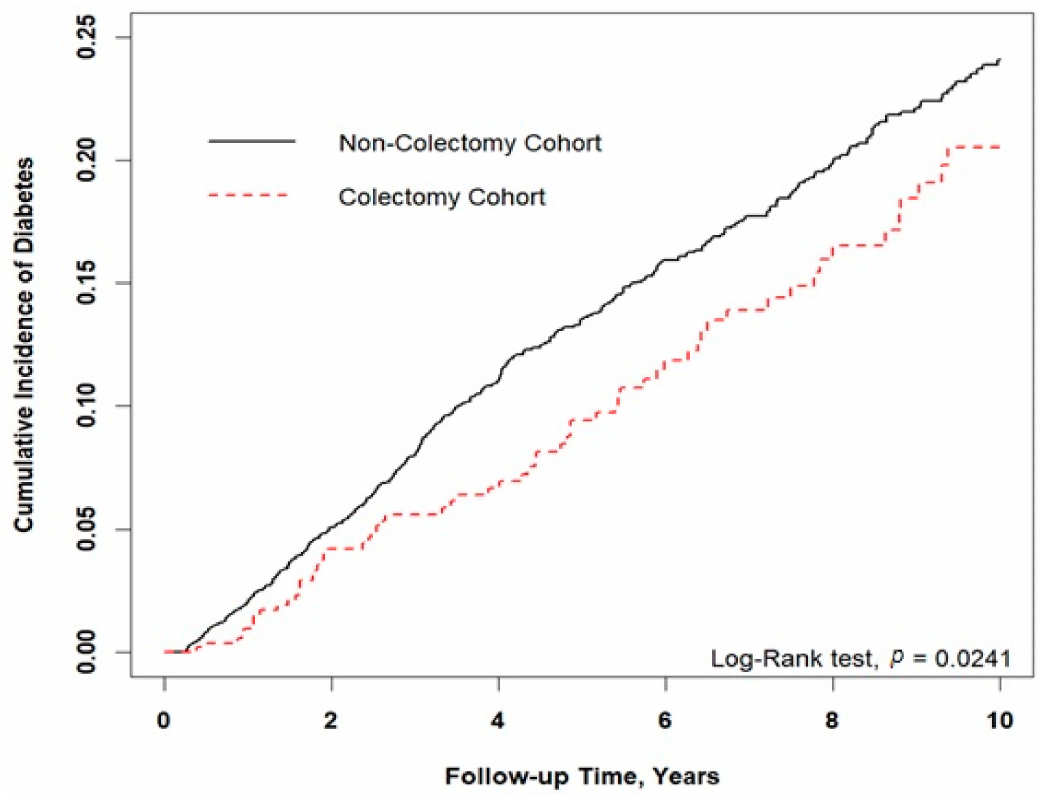
Figure 2. Results of Kaplan–Meier analysis for cumulative incidence of type 2 diabetes. Cumulative incidence of type 2 diabetes was lower in the colectomy cohort than the control cohort ( p =